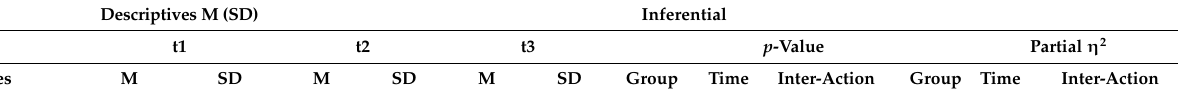
Table 2. Changes in cognitive status (MMSE, ACT) and emotional status (mood disturbance/well- being (CSRS-AMS) and depressive symptoms (GDS-SF